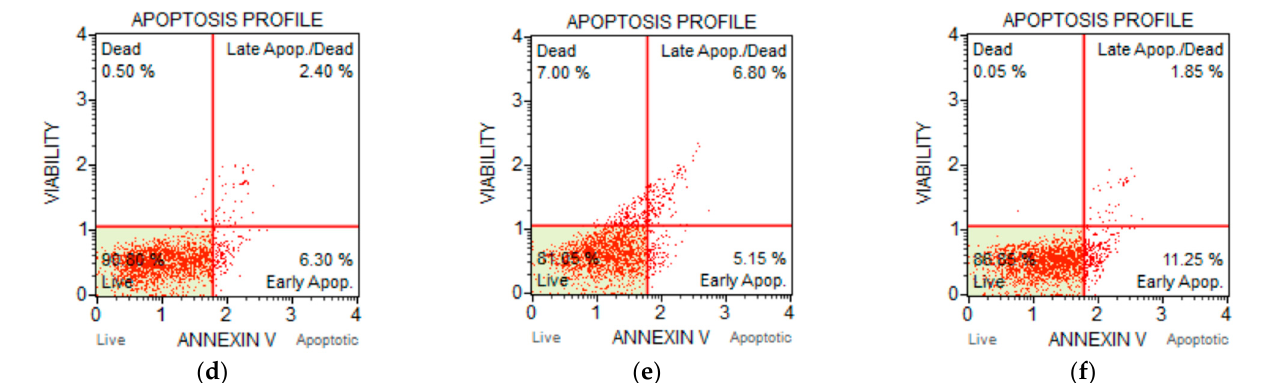
Figure 16. Apoptosis profiles for ( a ) untreated cells, ( b ) IgG, ( c ) zein, ( d ) NSP, ( e ) HA gel and ( f ) HA-NSP.